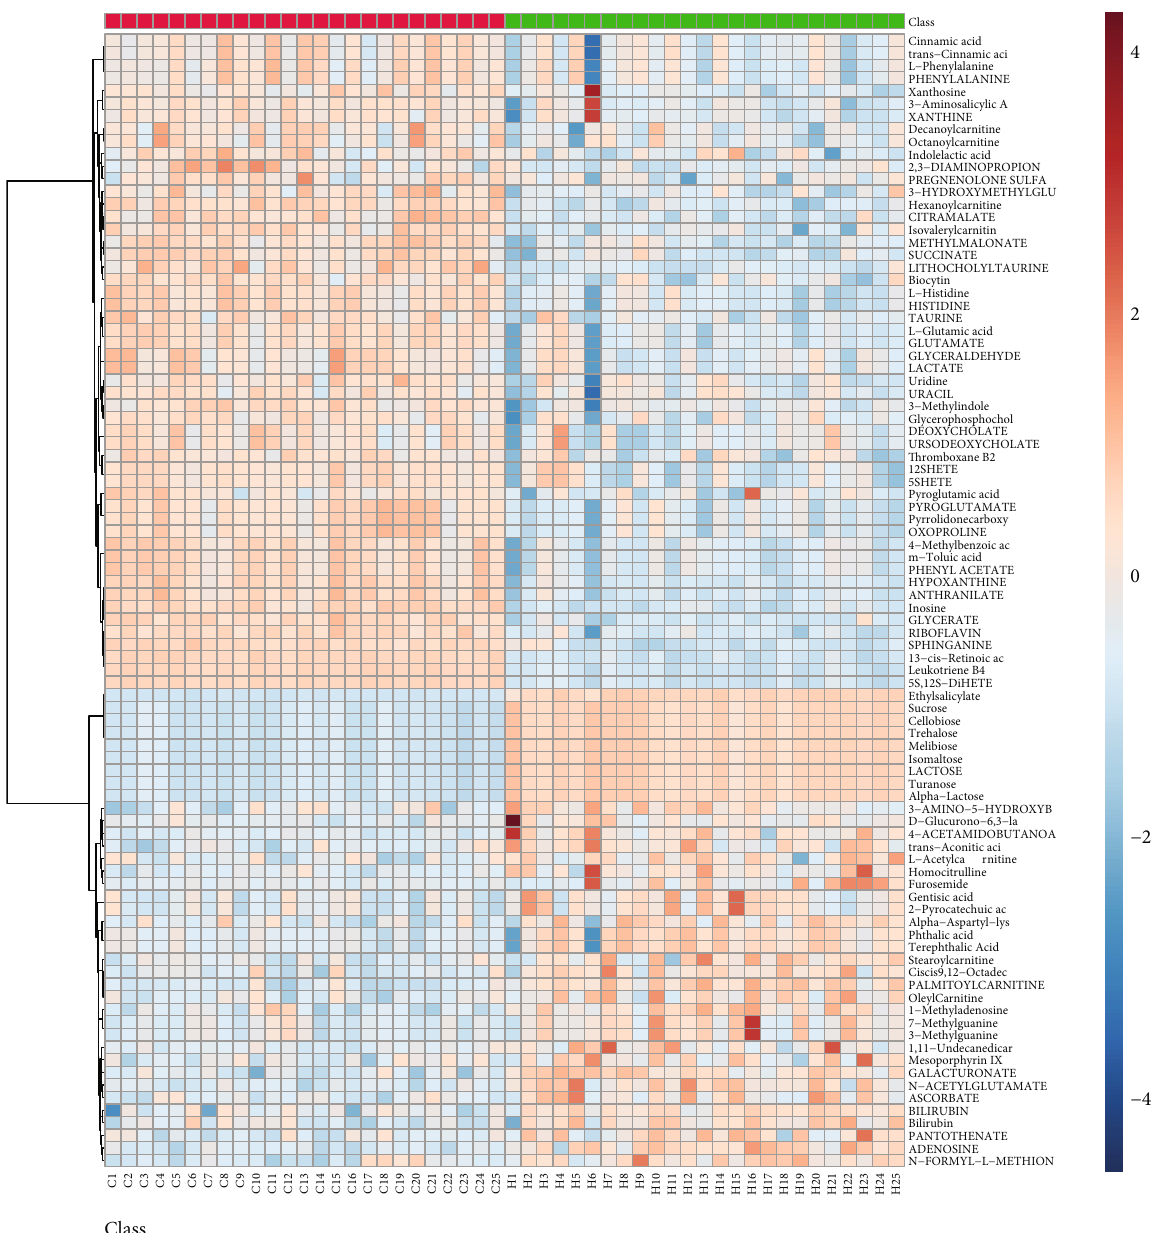
Figure 4: Metabolomic analyses of serum samples. (a) The PCA score plot using the fi rst two components. (b) The PLS-DA scores plot based on fecal metabolic pro fi les in the healthy and CHF group. (c) Heatmap showed the di ff erential proportion of 90 metabolites in the sample of CHF and healthy groups. The di ff erent colors of the circle represent di ff erent groups, blue circle: QC sample, green circle: CHF group, red circle: healthy group. C: healthy group; H: CHF